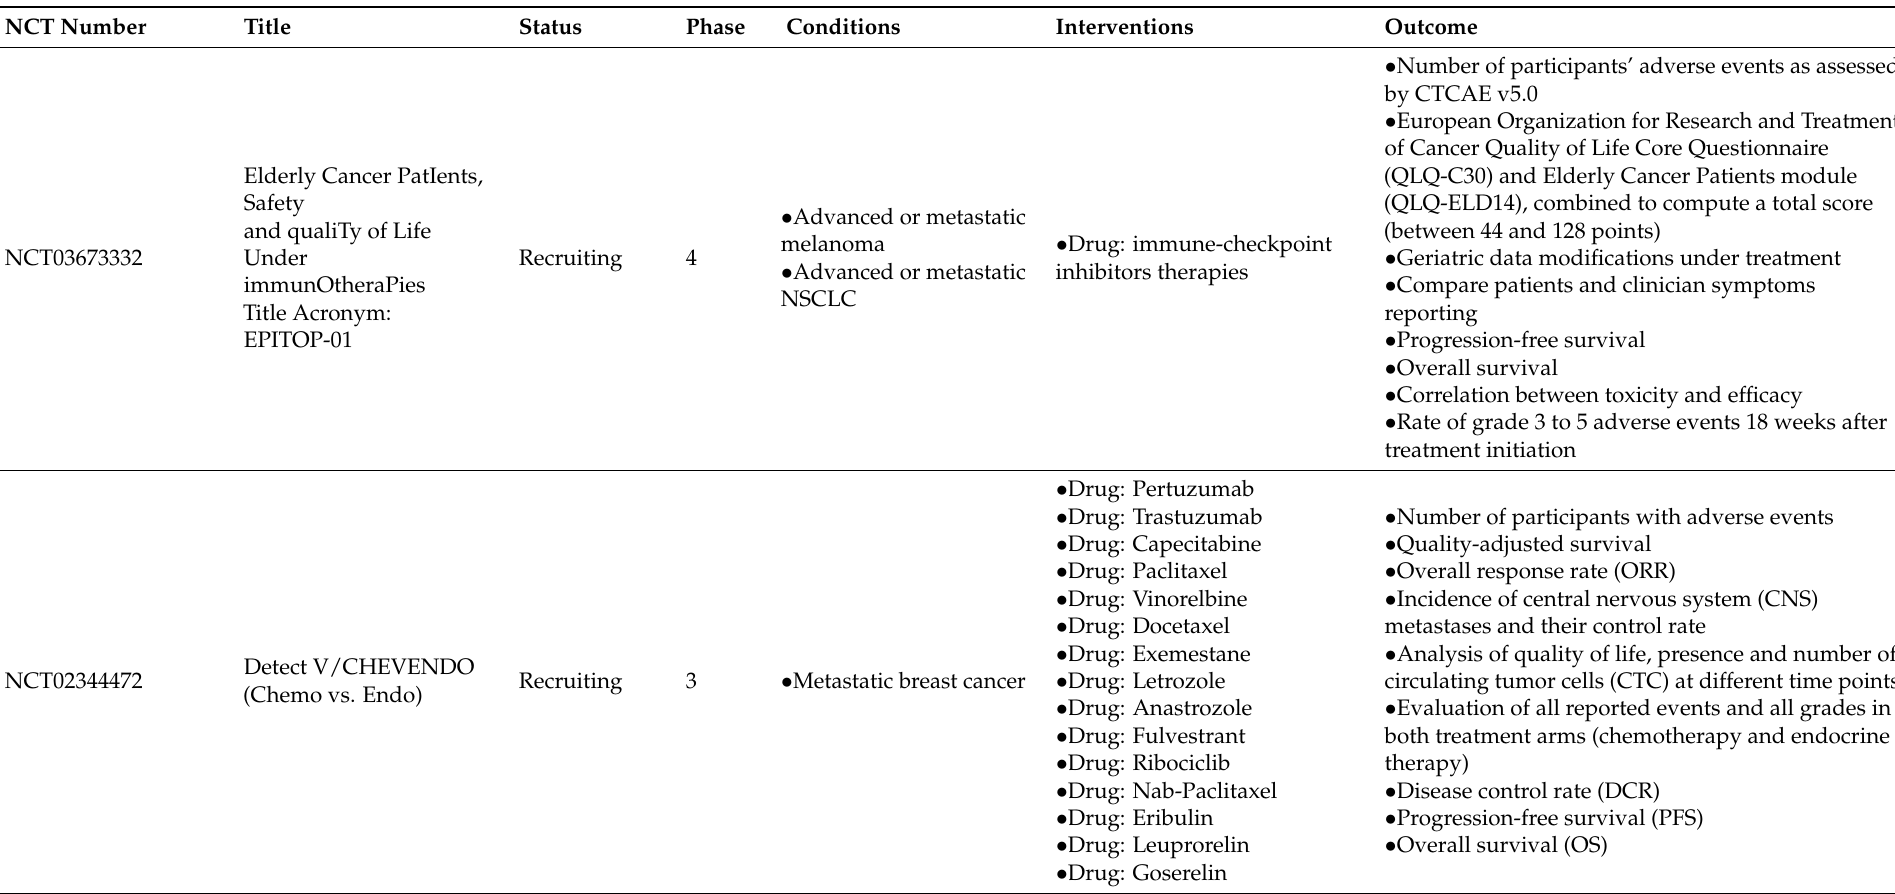
Table A3. Select clinical trials investigating the safety of targeted therapy—19 September 2021